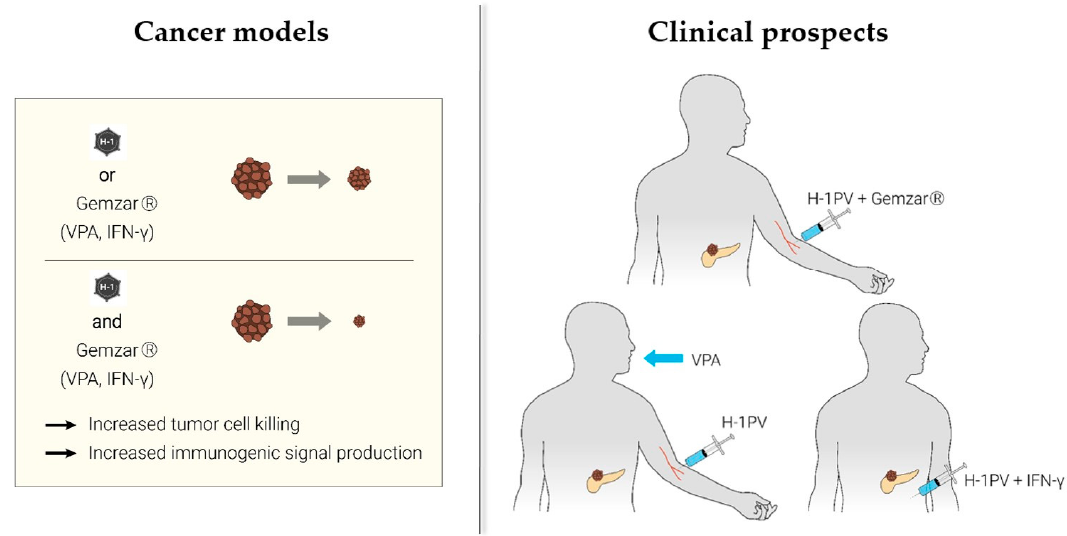
Figure 2. Parvovirus-based viro-immunotherapeutic combinations under development against pancreatic ducatl adenocarcinoma (PDAC). H-1PV-induced tumor cell lysis cooperates with gemcitabine-triggered programmed tumor cell death, valproic acid (VPA)-dependent epigenetic transcription regulation or interferon (IFN)- γ -induced immuno-stimulation to suppress PDAC. Preclinical data suggest that the immune system mediates, at least in part, this cooperation. H-1PV infection of tumor cells leads to the release of PAMPs/DAMPs, such as high-mobility group box 1 protein (HMGB1), which in turn alert the immune system to danger and mobilize an inflammatory antitumor immune response. Various aspects of H-1PV-, gemcitabine-, VPA- and IFN- γ -exerted immunomodulation may converge and synergize upon exposure of the host immune system to the respective combinations. The underlying mechanisms remain to be elucidated in detail by gathering extensive clinical experience. For details and references, see main text.